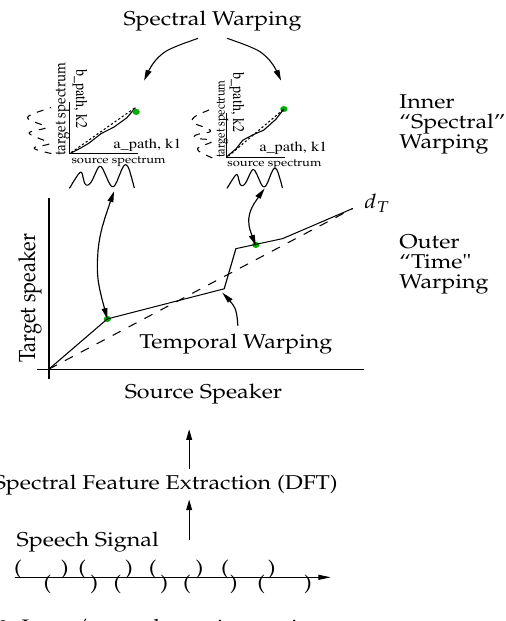
Figure 3. Inner/outer dynamic